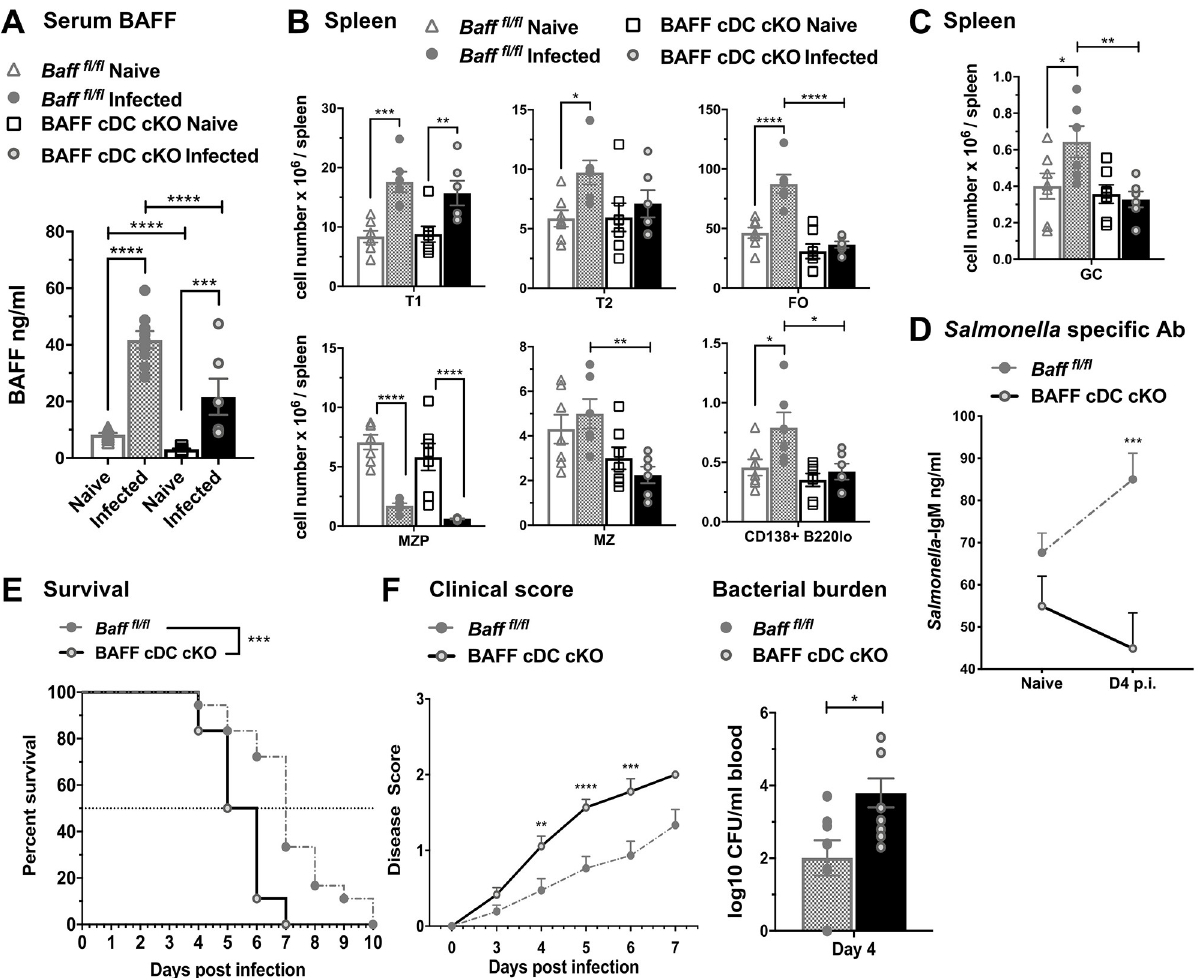
Fig 7. BAFF from cDCs is required for protective immune responses to S . typhimurium infection. (A-C) Baff fl/fl and Baff fl/fl zDC Cre (BAFF cDC cKO) mice were infected i.p. with 500 CFU S . typhimurium . Serum (A) and spleens (B and C) were harvested from na ï ve and day 4 infected mice. (A) BAFF titers in the serum were measured by ELISA. (B) Absolute numbers of total splenic B cell subsets (T1, T2, FO, MZP, MZ and B220lo CD138 + plasma cells) and (C) GC B cells were determined by flow cytometry. (A-C) Data are combined from two independent experiments (n = 6–14). (D-F) Baff fl/fl and BAFF cDC cKO mice were infected i.p. with 25 CFU S . typhimurium . (D) Salmonella specific IgM Abs in the serum were measured by ELISA. (D) Data are combined from three independent experiments (n = 17–19). (E and F) Data show survival (E), clinical scores (F, left panel ) and bacterial burdens (F, right panel ) were measured at day 4 p.i. by plating blood collected via the retro-orbital route. (E and F, right panel )) For survival studies and clinical scores, data were combined from two independent experiments: Baff fl/fl and BAFF cDC cKO n = 18. (F) Data of bacterial burdens were summarized from two independent experiments (n = 8–9). (A-D) Statistics were determined by Two-Way Anova with Holm-Sidak multiple comparisons test. (E) A log-rank test for significance was performed to analyze survival data. (F, left panel ) Significance in clinical scores were determined by Two-Way Anova with Holm-Sidak’s multiple comparisons test. (F, right panel ) unpaired Student t test was used to determine significance in bacterial burdens. Bar graphs show means ± SEM; � p < 0.05, �� p < 0.01, ��� p < 0.001, ���� p < 0.0001.